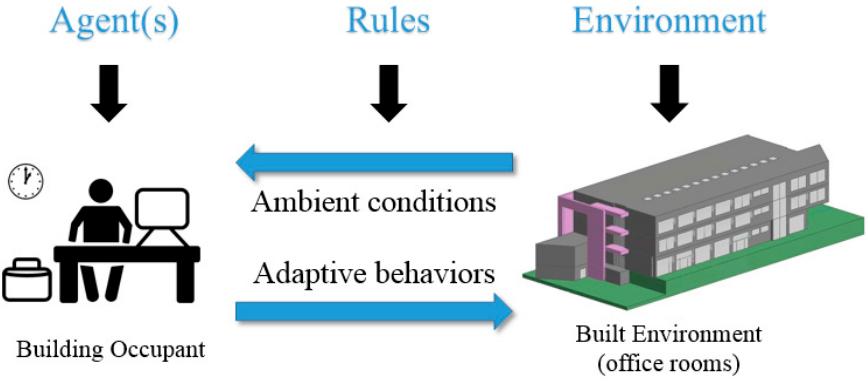
Figure 1. Instantiation of a general agent–based modeling (ABM) in the context of the built envi-